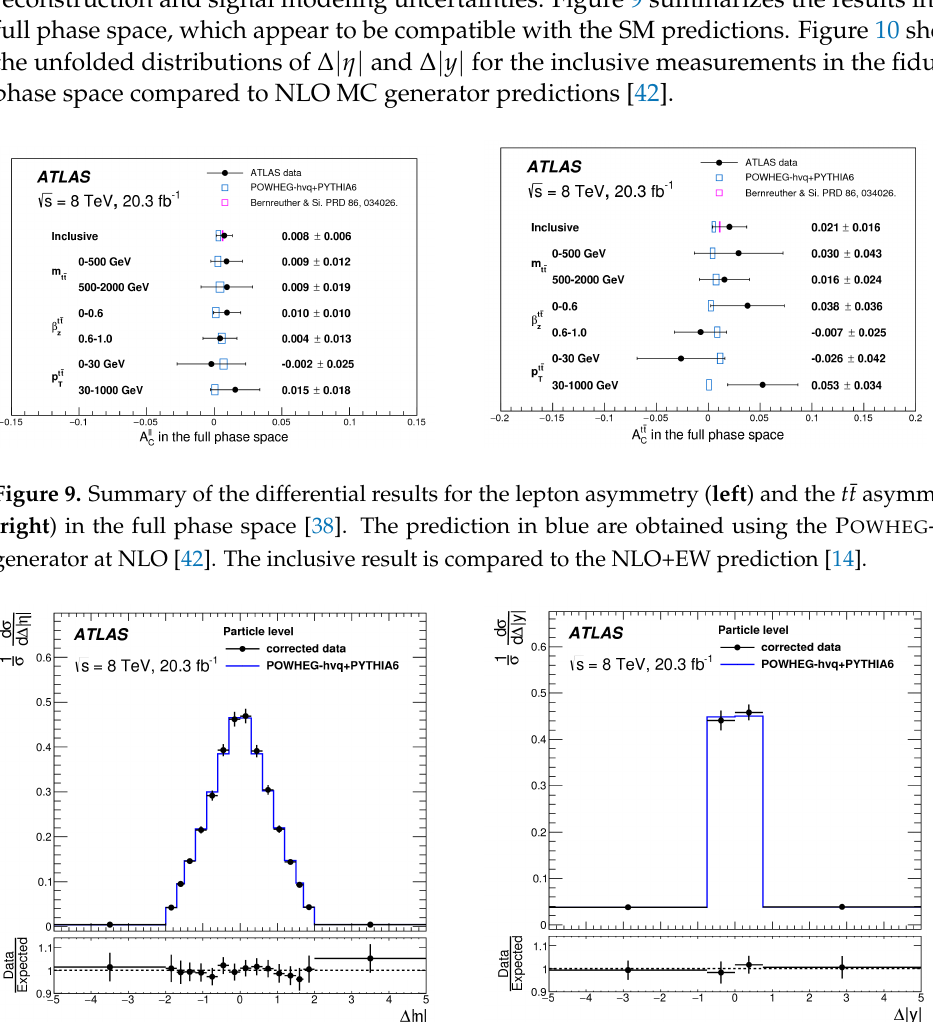
Figure 10. Unfolded data distribution for ∆ | η | ( left ) and ∆ | y | ( right ) [38] compared to the predictions from the P OWHEG -hvq generator at NLO